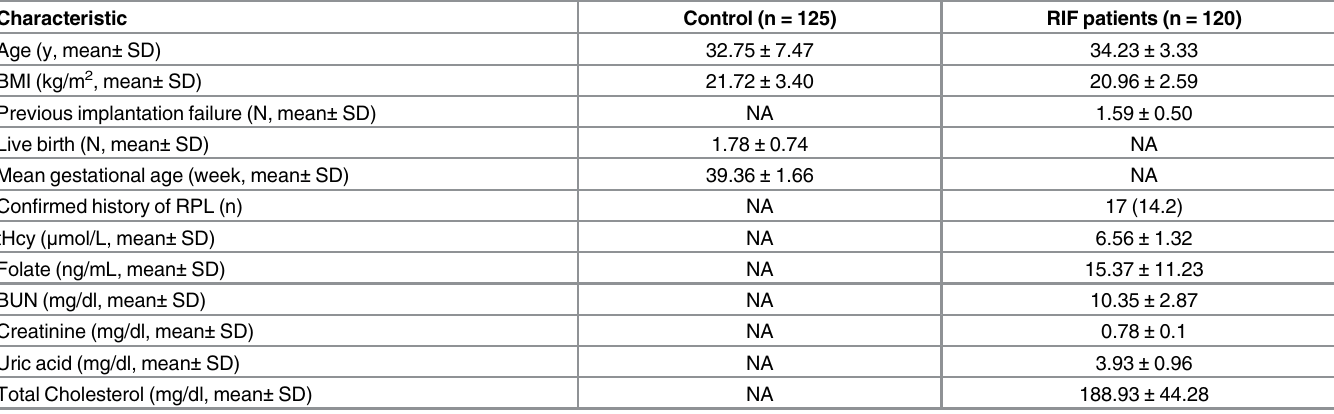
Table 1. Clinical characteristics of RIF patients and control